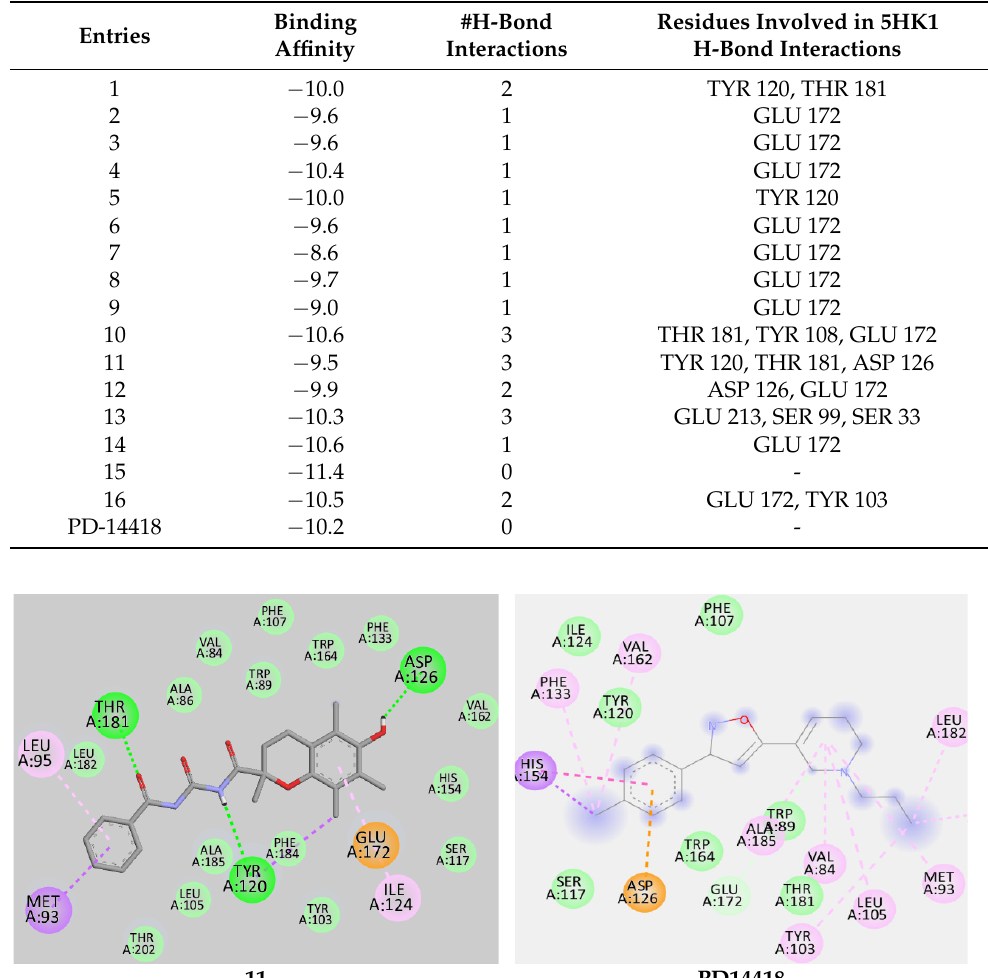
Figure 3. 2D Interactions of representative compound 11 and PD14418 with 5HK1. Legend: (Dark green, Conventional H ‐ bonding, Light green ( π‐ donor hydrogen), Purple ( π‐ sigma), Pink ( π‐ alkyl), and Orange ( π‐ anion) polar and non ‐ polar interactions.